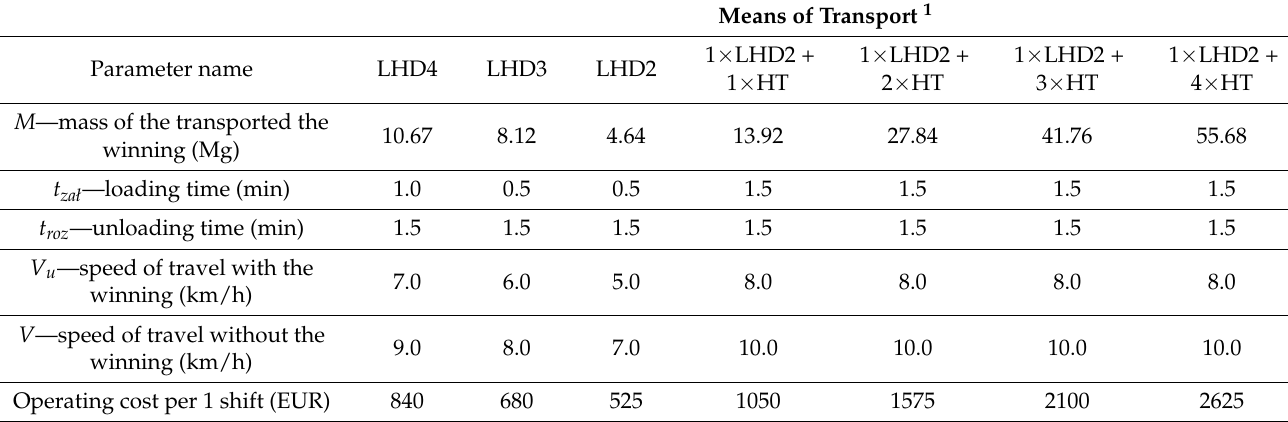
Table 3. List of computational parameters of loaders and haul trucks for the needs of simulation